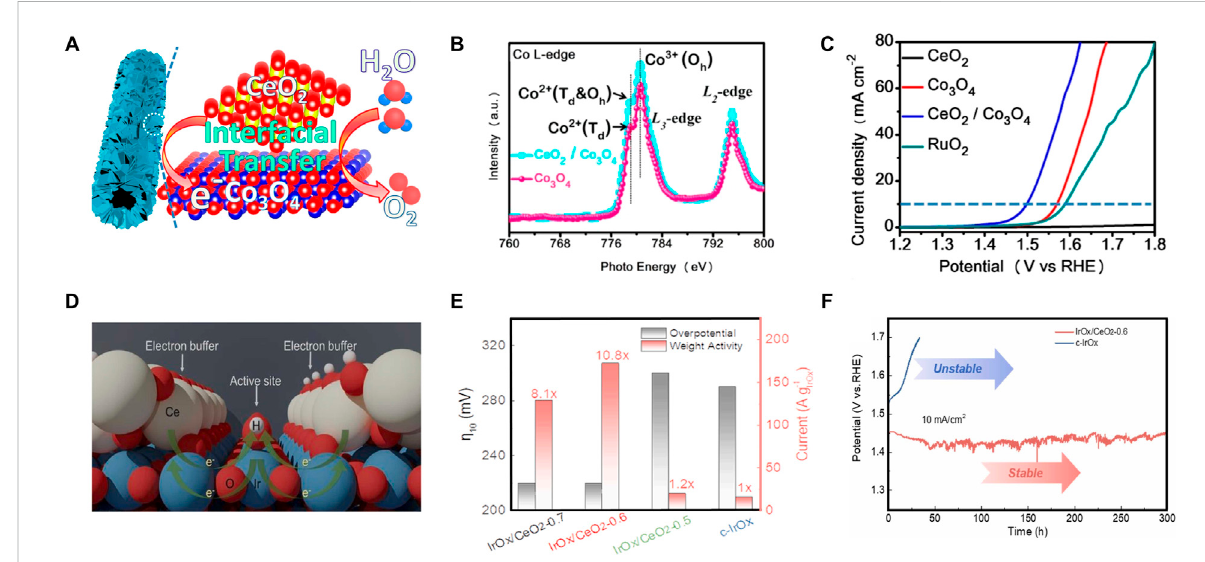
FIGURE 9 Applications of CeO 2 in electrolytic water-splitting: (A – C) The interaction between catalytically inactive CeO 2 and spinel structure Co 3 O 4 (A) , and the characteristics of chemical status (B) and electrocatalytic activity (C) for the as-made Co 3 O 4 -based catalysts. Reproduced with permission (Qiu et al., 2019). Copyright 2019, American Chemical Society. (D – F) Catalysis mechanism of IrO x /CeO 2 (D) and the electrocatalytic performances (E,F) . Reproduced with permission (Gou et al., 2022). Copyright 2022,